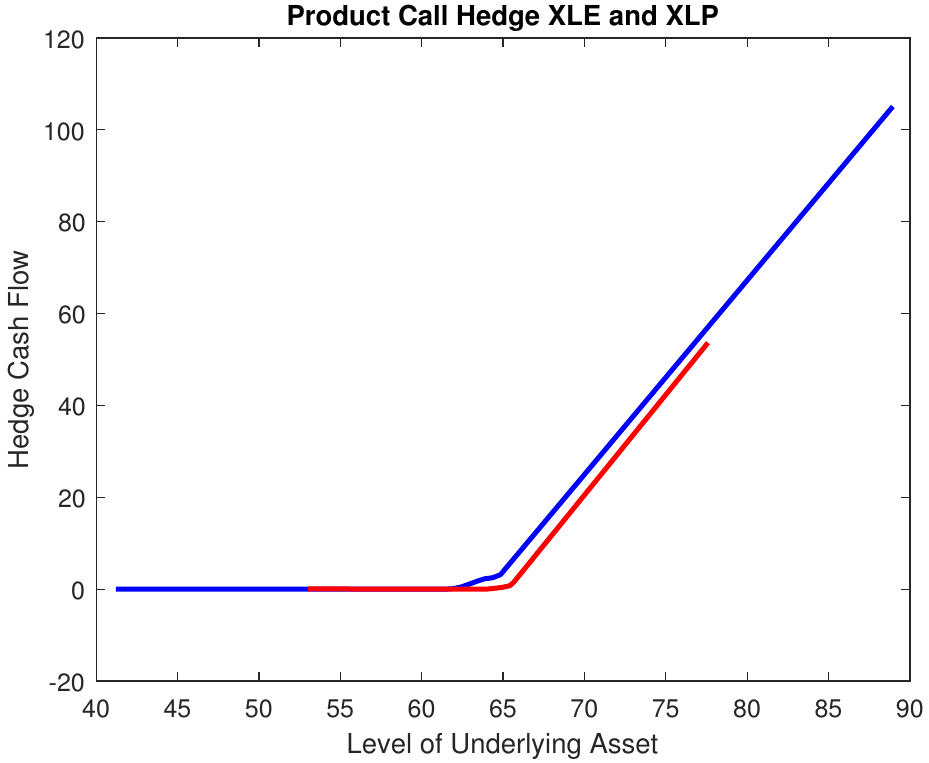
Figure 3. Hedge cash flows accessed by risk charge minimizing hedge. The blue curve displays the XLE hedge, and the red curve presents the XLP hedge. The stress level used was 0.75 for the distortion minmaxvar.